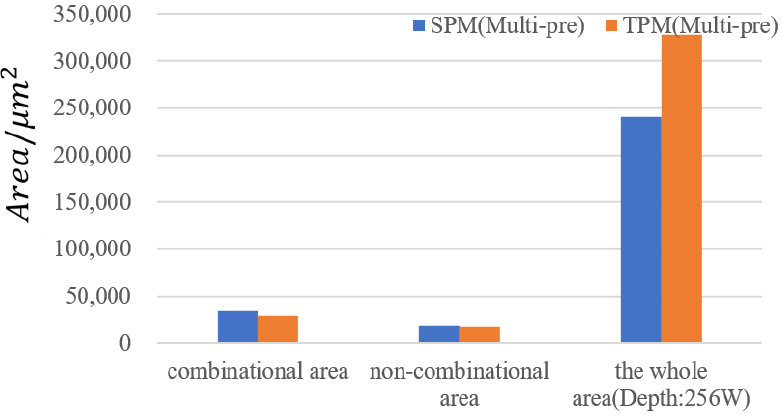
Figure 9. The logic area costs for a multiprecision computation